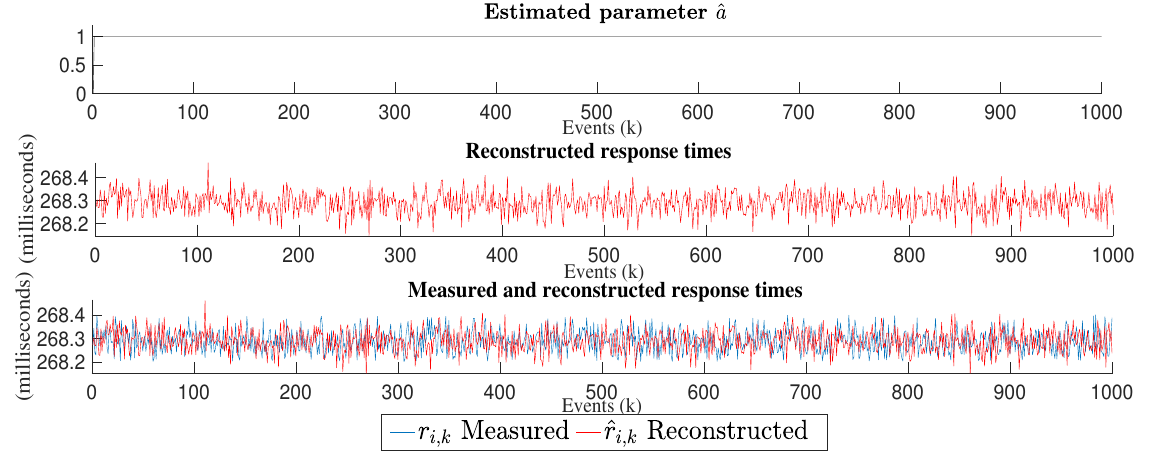
Figure 10. Estimated parameter ˆ a graph, reconstructed response times ˆ r i , k and comparative graph of measured response times r i , k vs. reconstructed response times ˆ r i , k for the 128 × 128 matrix inversion experiment.